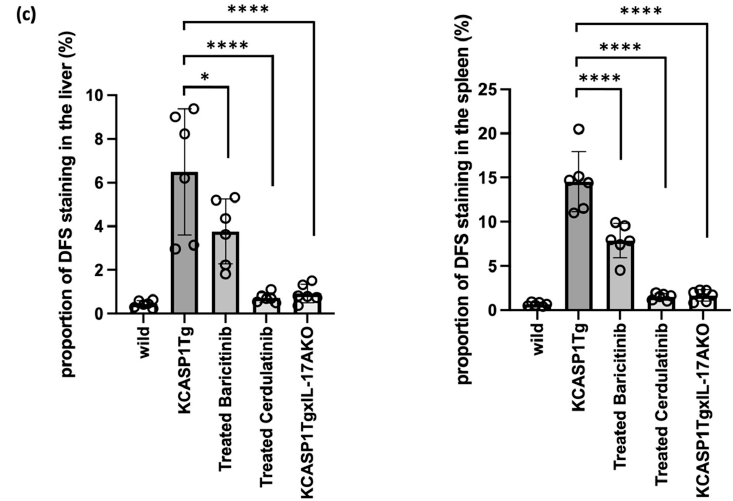
Figure 4. Effect of administration of JAK inhibitors and IL-17A ablation. KCASP1Tg mice were treated with baricitinib or cerdulatinib from 8 to 16 weeks of age (Treated Baricitinib and Treated Cerdulatinib, respectively; n = 6 per group). Histopathological investigation was also performed in IL-17A - /KCASP1Tg mice (n = 6). ( a , b ) Histopathological analysis of treated and untreated KCASP1Tg was performed. Amyloid deposition in the liver was recovered by baricitinib administration and further recovered in cerdulatinib-treated KCASP1Tg mice. IL-17 deletion rescued the amyloidosis dramatically. Similarly in the spleen, massive deposition in the marginal zone is reduced in cerdulatinib-treated KCASP1Tg mice, and rescued in IL-17A - /KCASP1Tg mice. In particular, CD20-positive cells are recovered by these treatments. Images at ×100 magnification are shown. ( c ) DFS-positive areas were recovered in baricitinib-and cerdulatinib-treated KCASP1Tg mice and in IL-17A - /KCASP1Tg mice (left; liver, right; spleen). All data are expressed as the mean±SD. * p < 0.05, **** p < 0.0001 compared to wild mice by ordinary one-way ANOVA test.